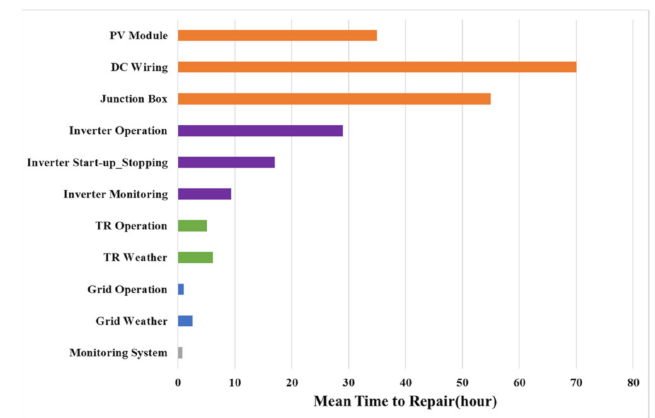
Figure 4. Mean time to repair failures in PV systems.